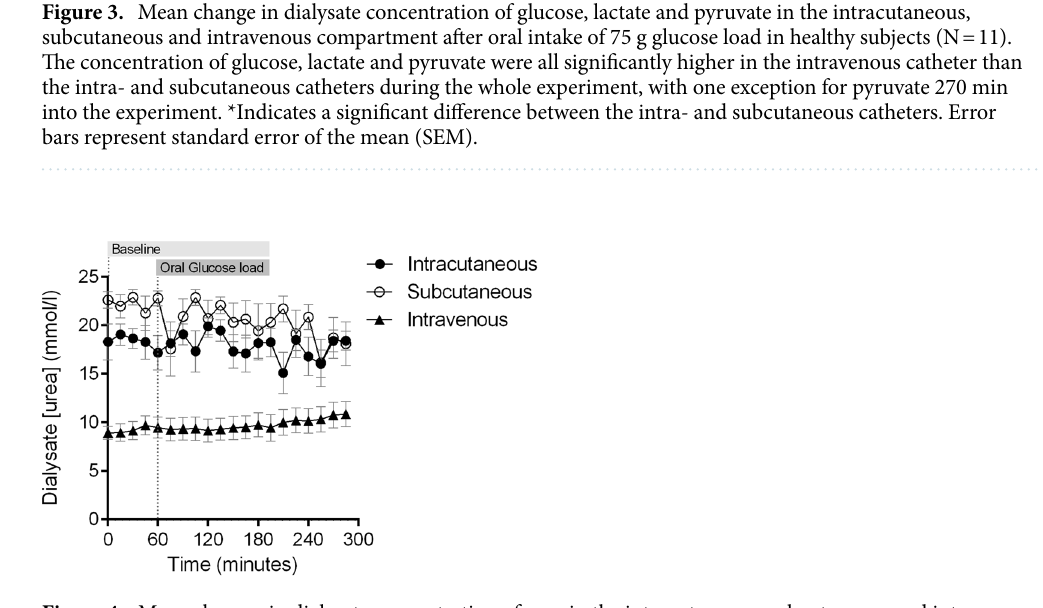
tration in serum measured with electrochemiluminescence compared to ultrasensitive ELISA showed a slope value of 0.70 and R 2 of 0.92. Insulin concentration measured with ultrasensitive ELISA directly in serum was